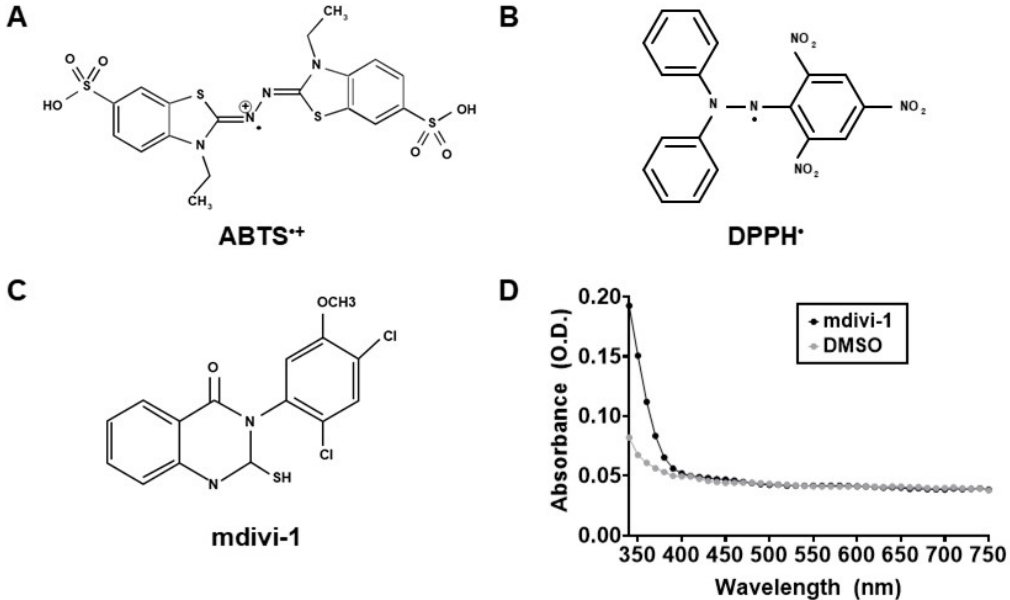
Figure 1. Mitochondrial division inhibitor-1 (mdivi-1) structure, absorbance, and the free radicals used to measure its antioxidant activity. ( A ) 2,2 ′ -Azino-bis(3-ethylbenzothiazoline-6-sulfonic acid) (ABTS) radical. ( B ) 2,2-Diphenyl-1-picrylhydrazyl (DPPH) radical. ( C ) Mdivi-1 structure. ( D ) Absorbance spectra of mdivi-1 (100 μ M) and dimethyl sulfoxide (DMSO, 0.2%) in solution. O.D., optical density.